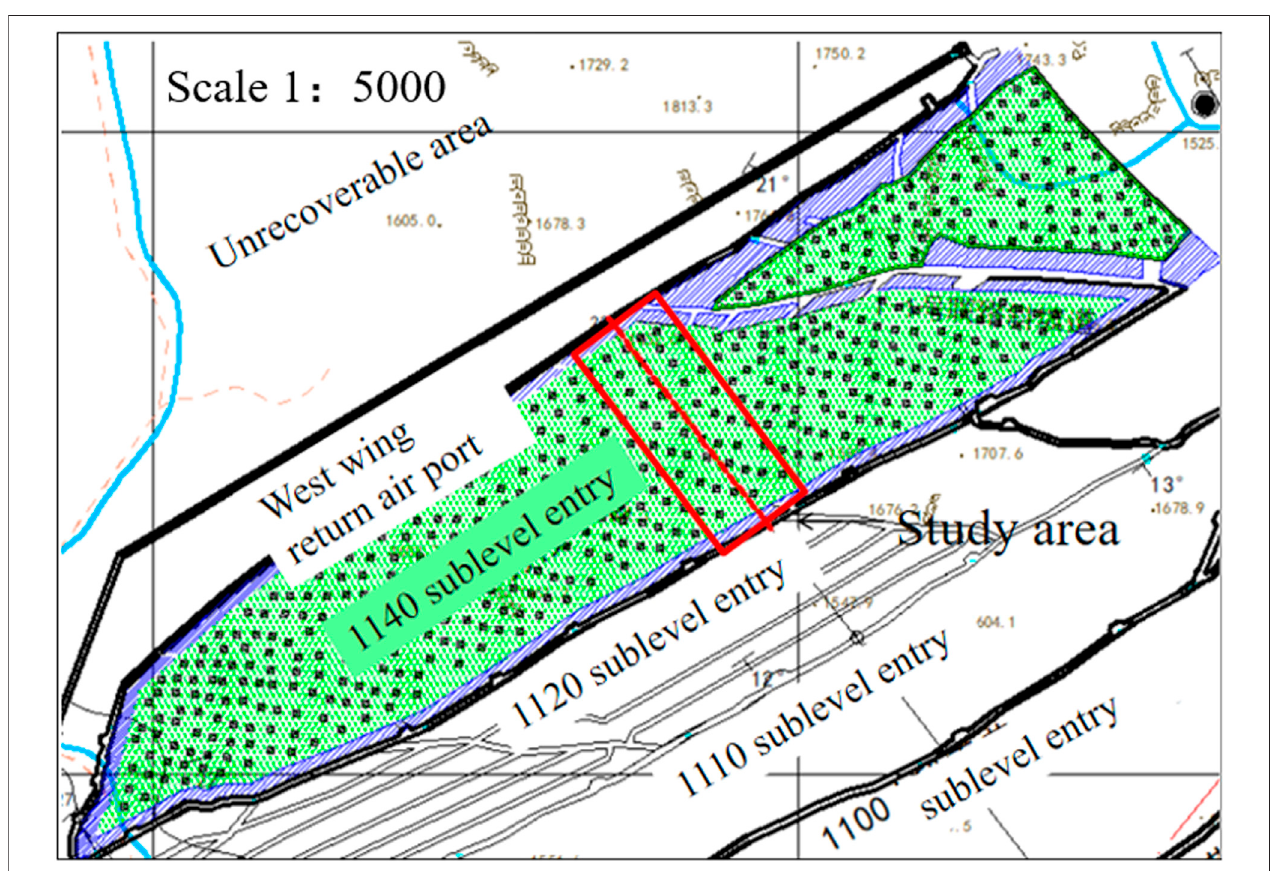
FIGURE 1 | Plan of roadway in section IV of Wawu Phosphate